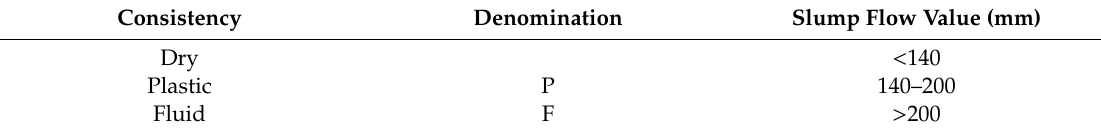
Table 6. Consistency types and denomination according to EN